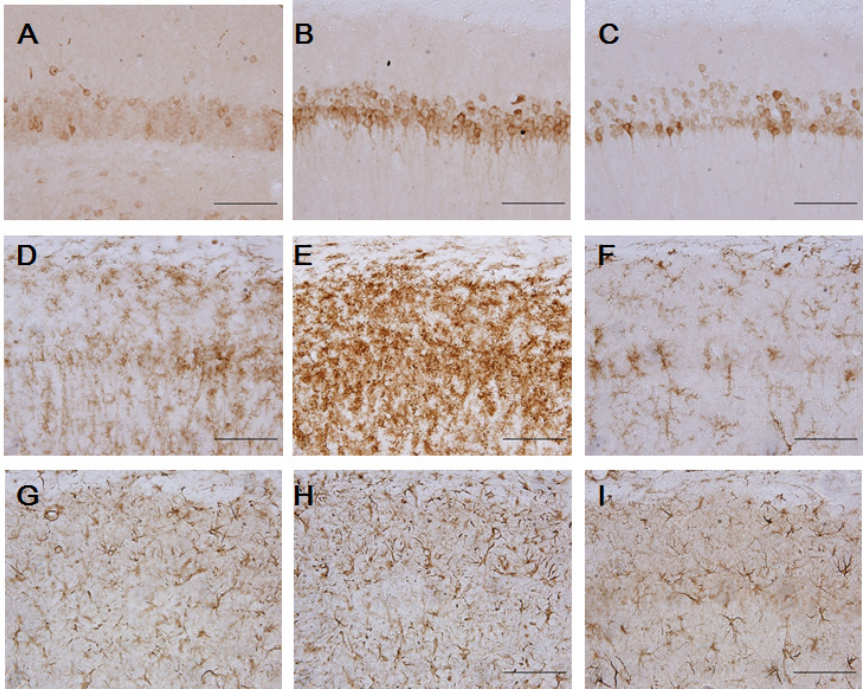
Figure 3. Inhibitory effect of TIPL on COX-2 ( A , B , C ), OX-42 ( D , E , F ), and GFAP ( G , H , I ) expression at 2 or 7 days after ischemia. Sham-operated group (A,D,G), control group (B,E,H), or TIPL 100 mg/kg treated group (C,F,I). Scale bar = 100 μ